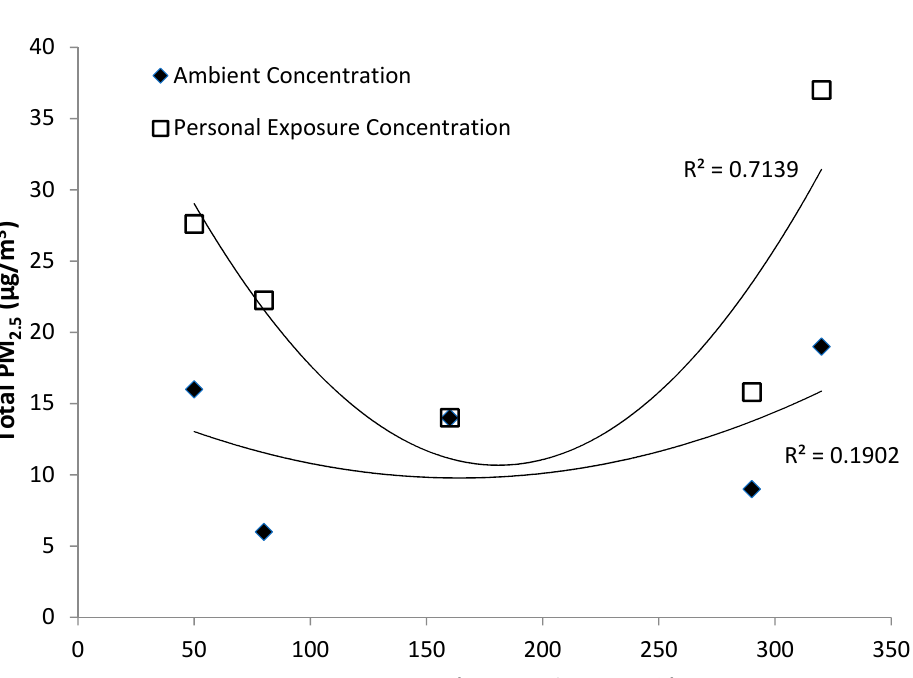
Figure 2. Influence of wind direction on personal exposure measurements and ambient PM 2.5 . A second order polynomial regression line of best fit was added to both personal exposure and ambient measurements. Residuals were significantly different from observed values for the ambient measurements (ANOVA, p = 0.03) but not personal exposure concentrations (ANOVA, p = 0.83).